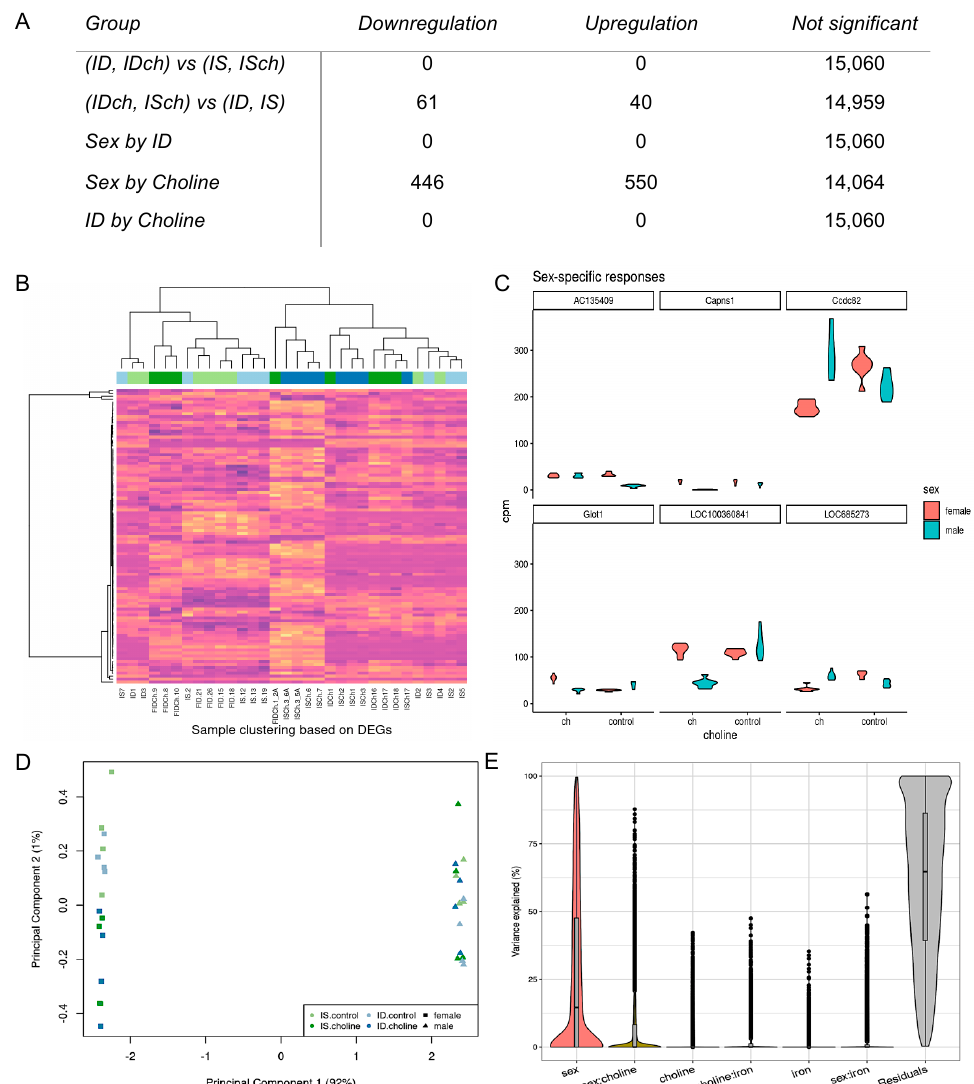
Figure 1. Bioinformatic integration of male and female RNA-seq datasets generated using different sequencing platforms. ( A ) Comparative analysis between groups showing a robust effect of sex − by − choline interaction on hippocampal gene expression. ( B ) Heatmap generated from unsupervised clustering showing a pattern that did not follow expected choline effects. Each bar represents gene expression in CPM, with purple being the lowest expression value and yellow being the highest. Blue and green bars at the top indicate the group assignment. ( C ) Top 6 representative genes showing sex − by − choline interaction effects. ( D ) Multidimensional plot showing a clear separation between sexes but not ID or choline treatment. ( E ) Analysis of variance revealed that variations in gene expression among combined libraries can be accounted for by sex.